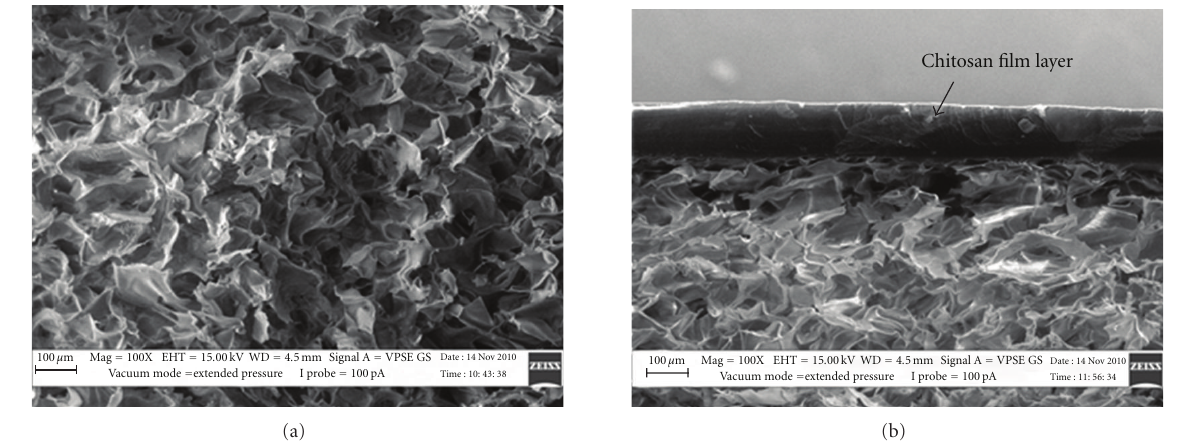
Figure 1: SEM images of CPSRT. (a) Surface of sponge layer. (b) Cross-sectional view of CPSRT that indicates a chitosan film combining a chitosan porous